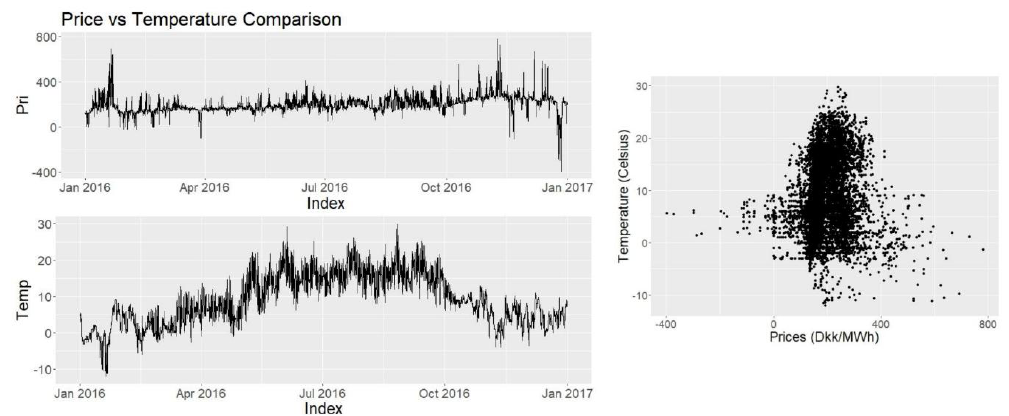
Figure 8. Price vs. Temperature.